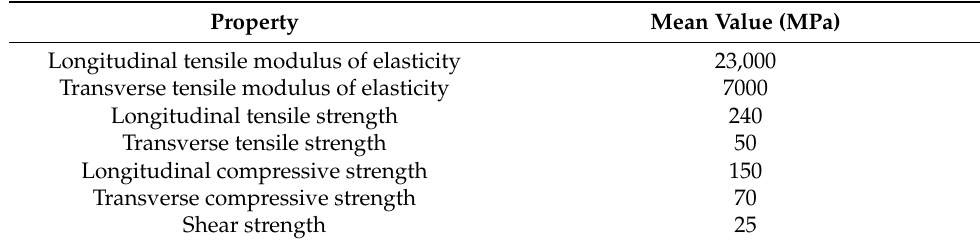
Table 1. Mechanical properties of pultruded GFRP. Property Mean Value (MPa) Longitudinal tensile modulus of elasticity 23,000 Transverse tensile modulus of elasticity 7000 Longitudinal tensile strength 240 Transverse tensile strength 50 Longitudinal compressive strength 150 Transverse compressive strength 70 Shear strength